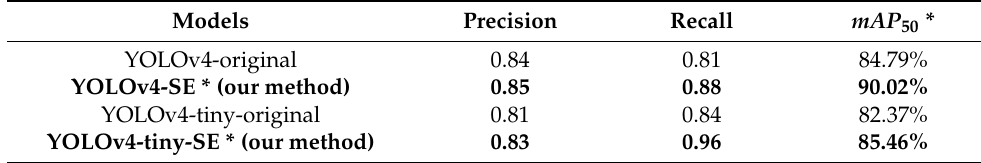
Table 4. Crack detection performance comparisons on customized datasets.